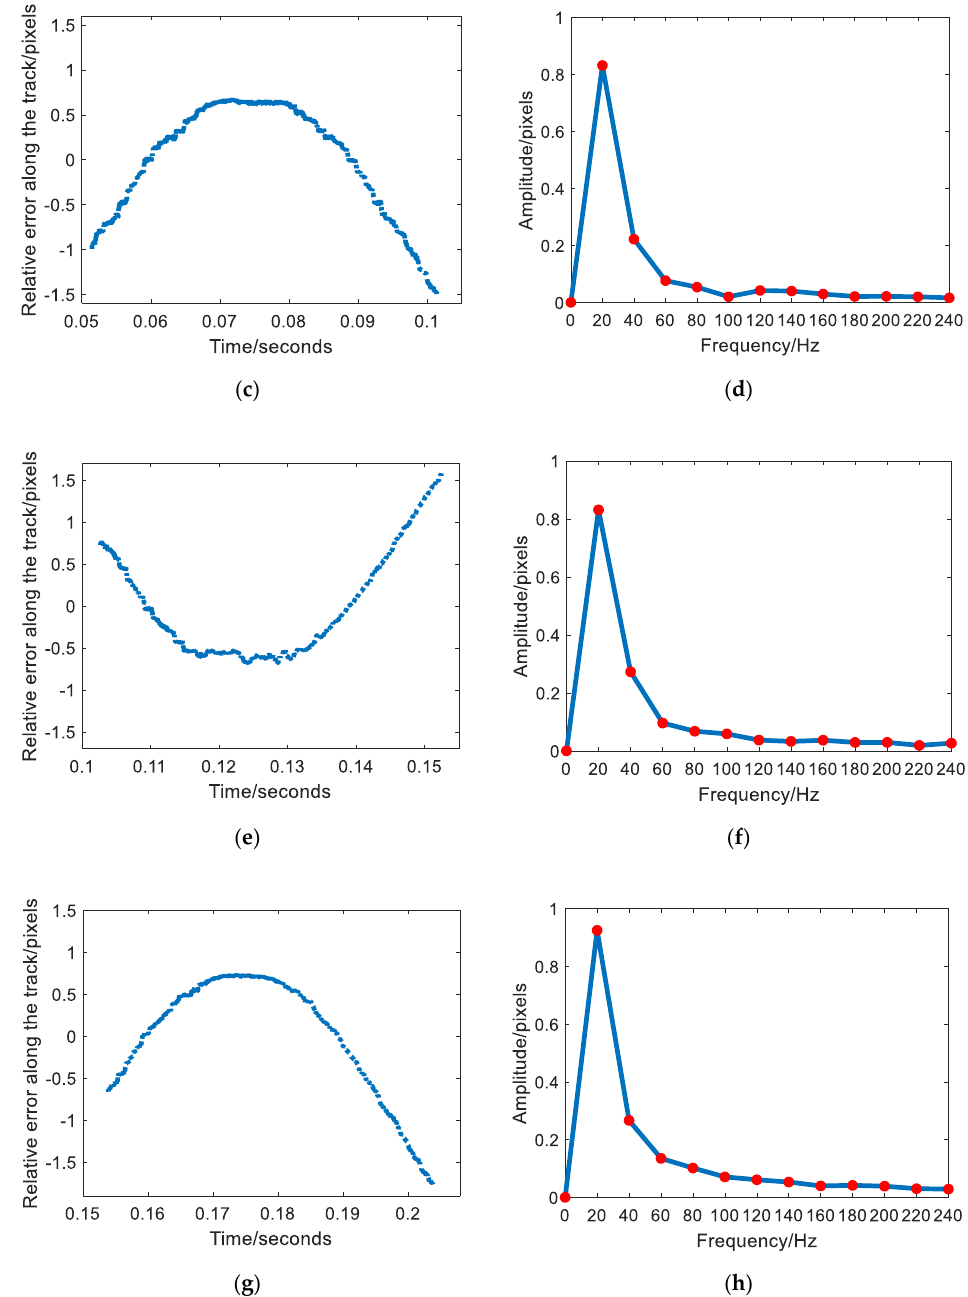
Figure 6. The 10-Hz Jitter detection curves and Fourier analysis results by single disparity map generated from two adjacent sequence images. ( a ): Jitter detection curve by image 1 – 2; ( b ) Fourier analysis results of jitter detection curve by image 1 – 2; ( c ) Jitter detection curve by image 2 – 3; ( d ) Fourier analysis results of jitter detection curve by image 2 – 3; ( e ) Jitter detection curve by image 3 – 4; ( f ) Fourier analysis results of jitter detection curve by image 3 – 4; ( g ) Jitter detection curve by image 4 – 5; ( h ) Fourier analysis results of jitter detection curve by image 4 – 5.